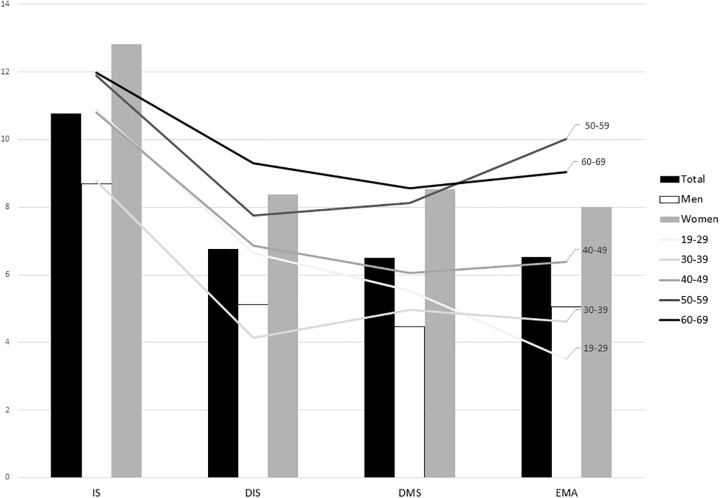
Prevalence of insomnia symptoms in men and women with different age groups.p was calculated by χ2 test. Abbreviations: IS = Insomnia Symptoms, DIS = Difficulty in Initiating Sleep; DMS = Difficulty in Maintaining Sleep; EMA = Early Morning Awakening.